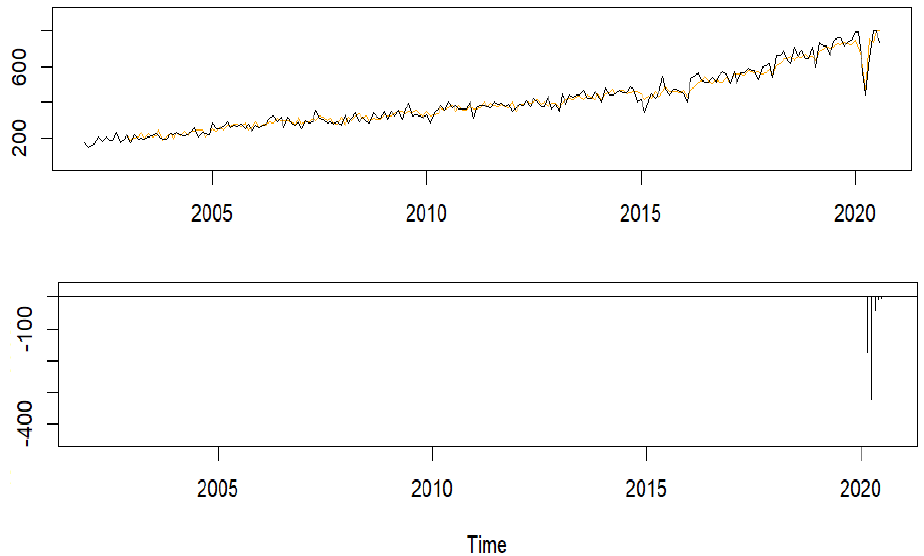
Figure 10. Donor transplant counts for the 65+-year-old group with the model fit ( top ) and the estimated COVID-19 effects ( bottom